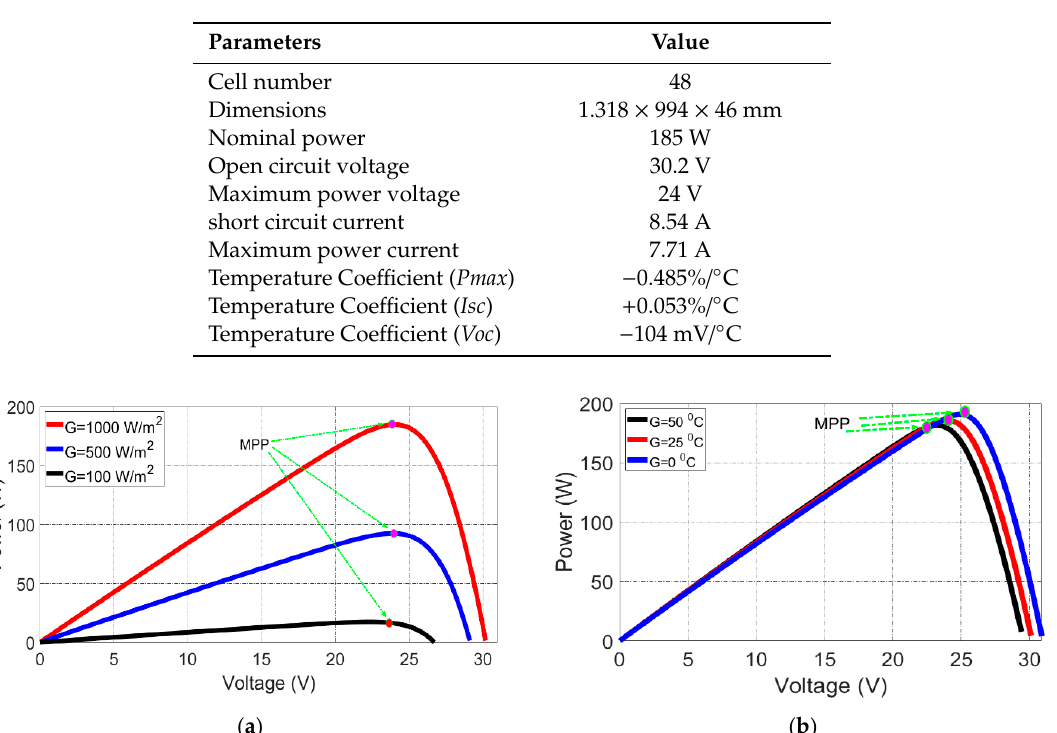
Table 1. PV module characteristics.